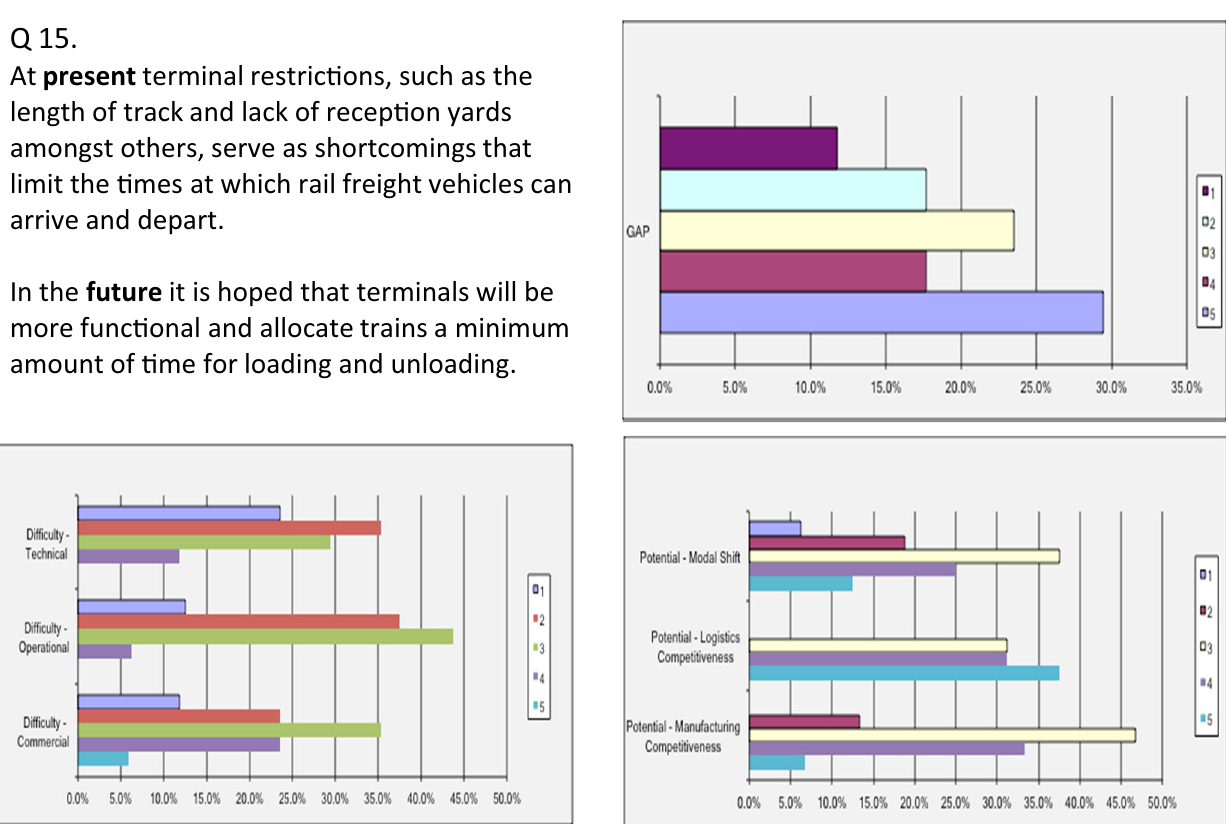
Fig. 2 Rail terminal ability to handle/tranship vehicles and